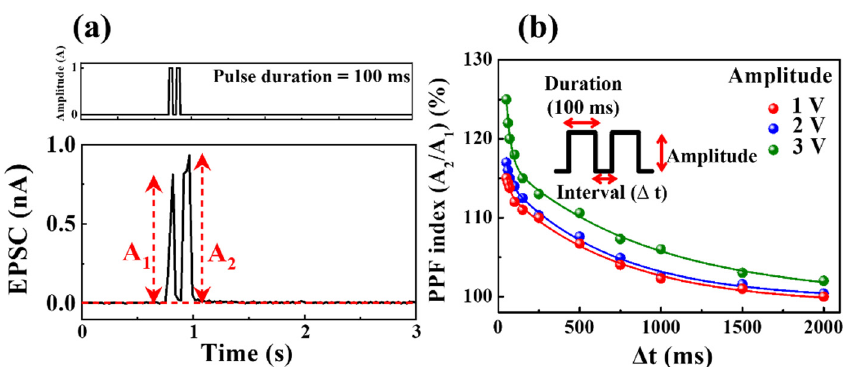
Figure 6. ( a ) EPSC induced by paired pre-synaptic pulses (amplitude: 1 V, duration: 100 ms, ∆ t = 50 ms, first peak: A 1 , second peak: A 2 ) on milk–Ta 2 O 5 hybrid crossbar array memristors. ( b ) PPF index as a function of ∆ t for two subsequent pre-synaptic pulses with amplitudes